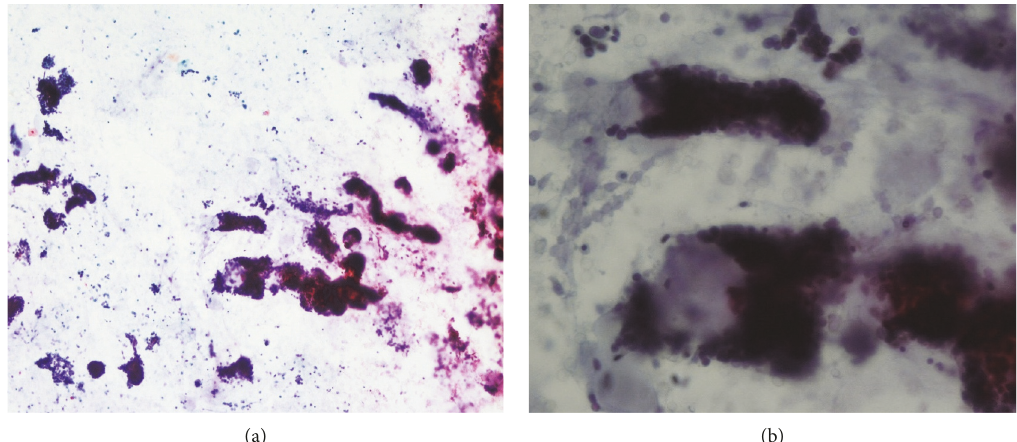
Figure 1: Cytology smears. (a) Sheets, three-dimensional clusters, and dispersed cells with hyaline materials (Papanicolaou stain, × 100). (b) Clusters of neoplastic cells surrounding hyaline globules (Papanicolaou stain, × 400).